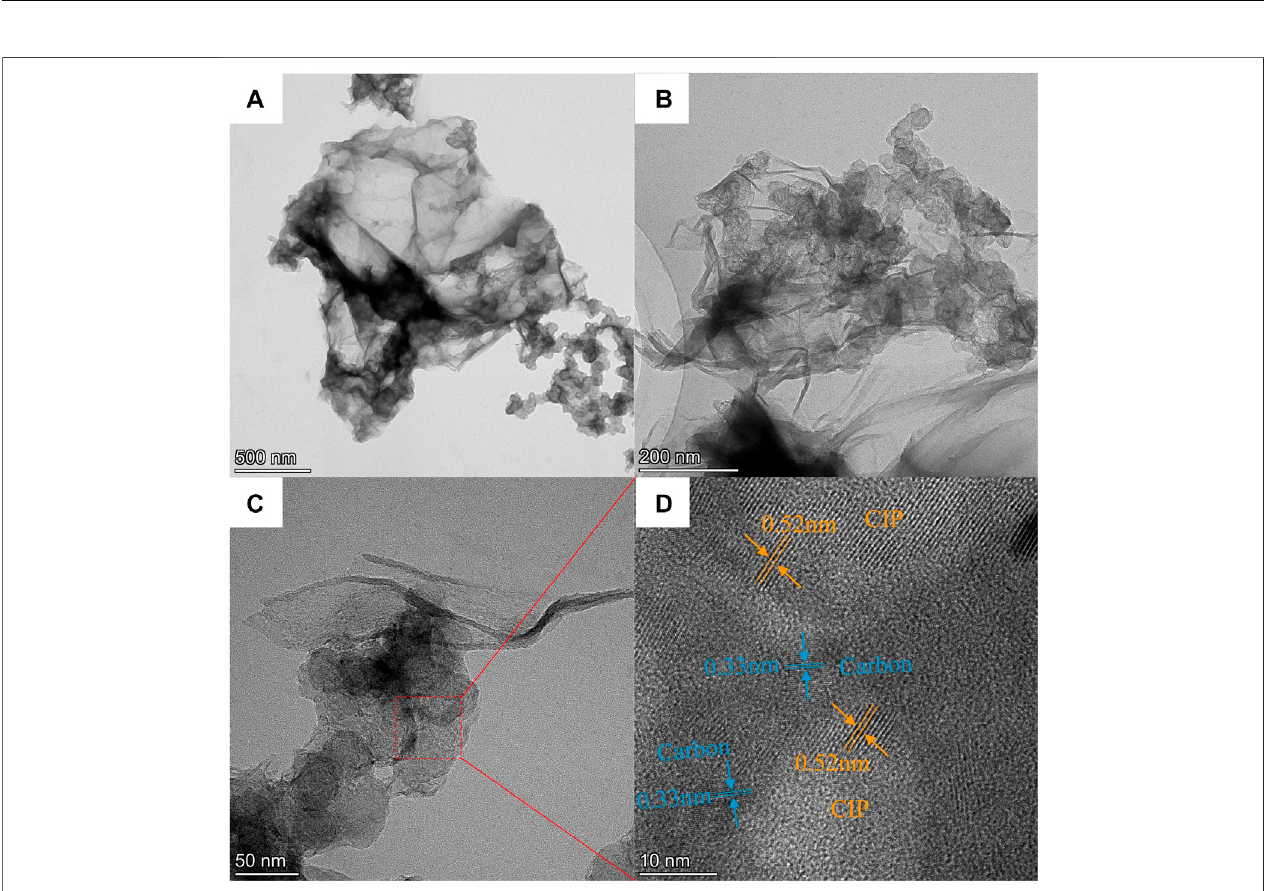
FIGURE4| TransmissionelectronmicrographofRGO-CB/CIP composite. (A,B) CBandCIPparticleswrappedwithRGO fi lm; (C) interfacebetweenCBandCIP; (D) high resolution TEM image of the selected part of (C) , showing lattice fringe spacing of CIP and CB.